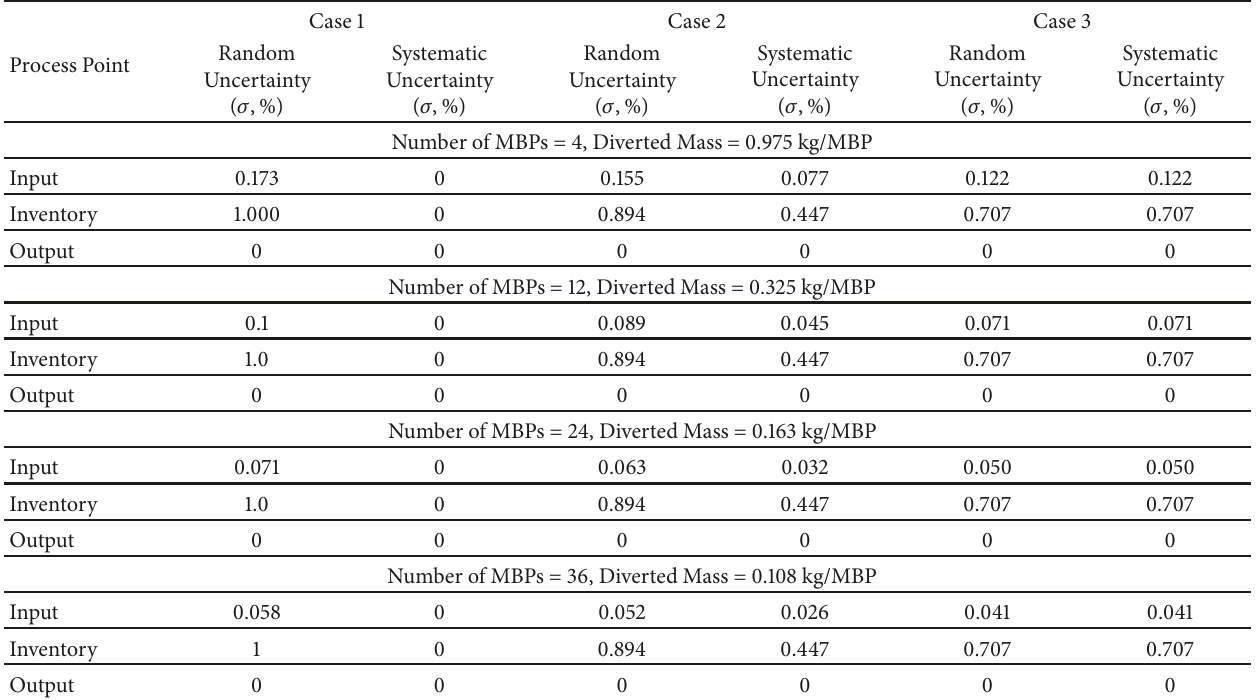
Table 4: Measurement model in intercomparative study